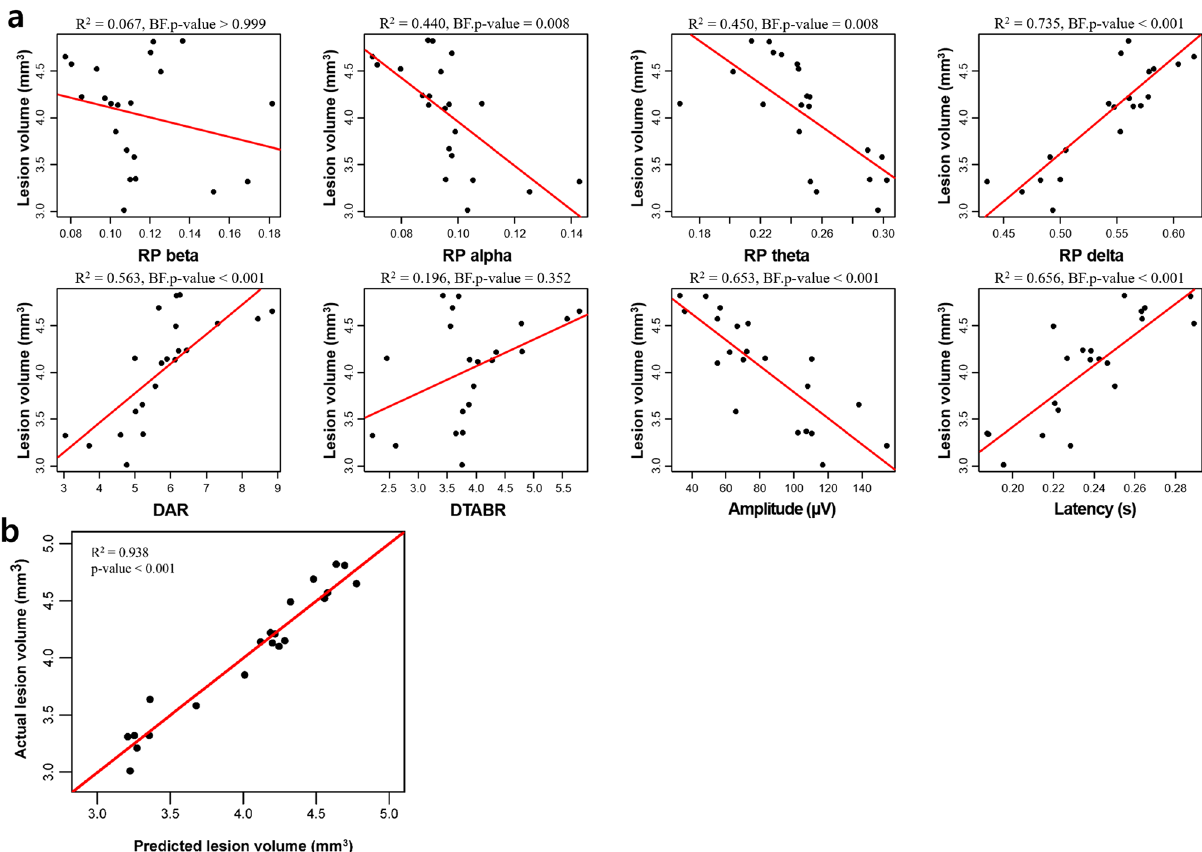
Figure 2. Scatter plots of individual data. ( a ) Scatter plots showing the relationship between each stroke-related EEG parameter and stroke lesion volume and ( b ) predicted stroke lesion volume using multiple linear regression model and actual stroke lesion volume. DAR, delta/alpha ratio; DTABR, (delta + theta)/(alpha + beta) ratio. BF. p value indicates Bonferroni corrected p